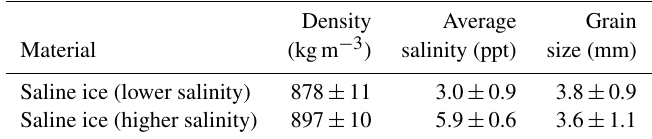
Table 1. Physical properties of as-grown saline ice.